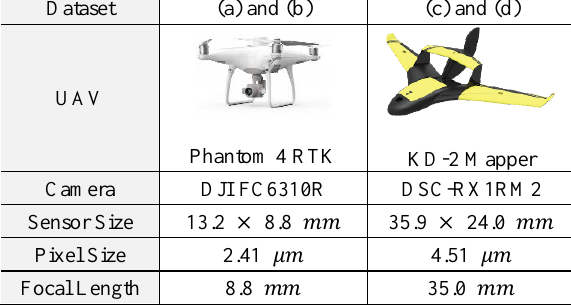
Table 1. Flight trajectory and locations of acquired images